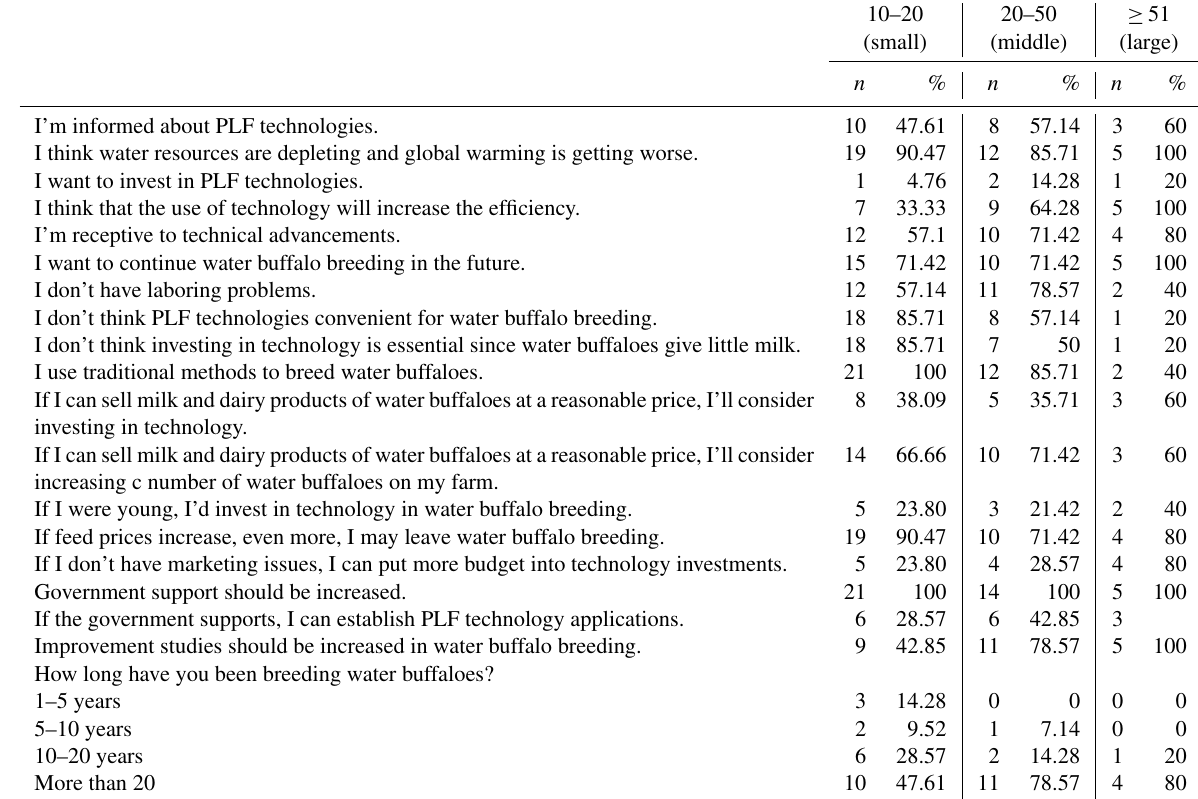
Table 3. PLF technology survey questions to evaluate in the SWOT